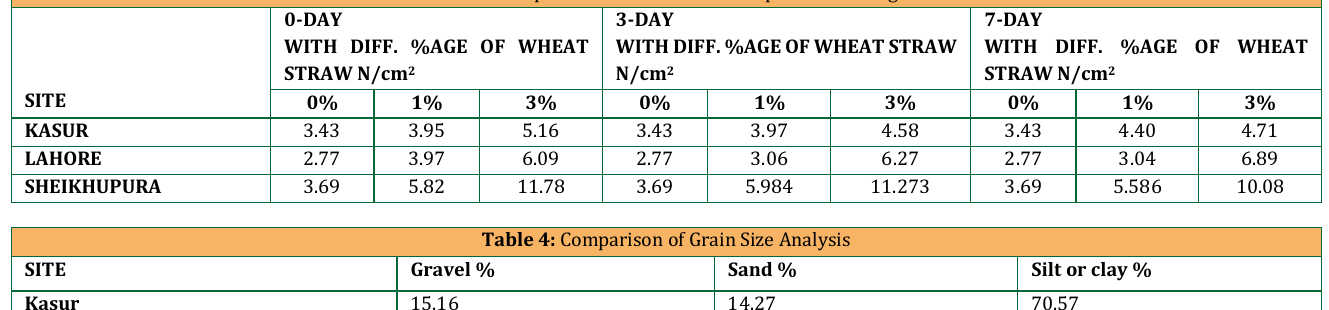
Table 3: Comparison of Unconfined Compressive Strength